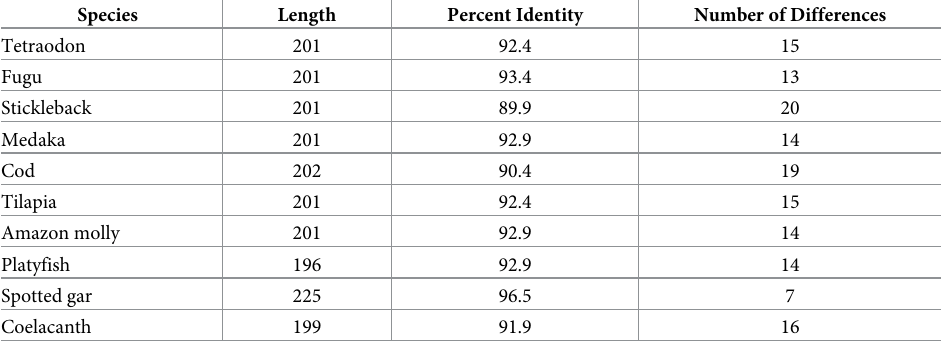
Table 8. Identities with 198-amino acid zebrafish ZMAT2 in